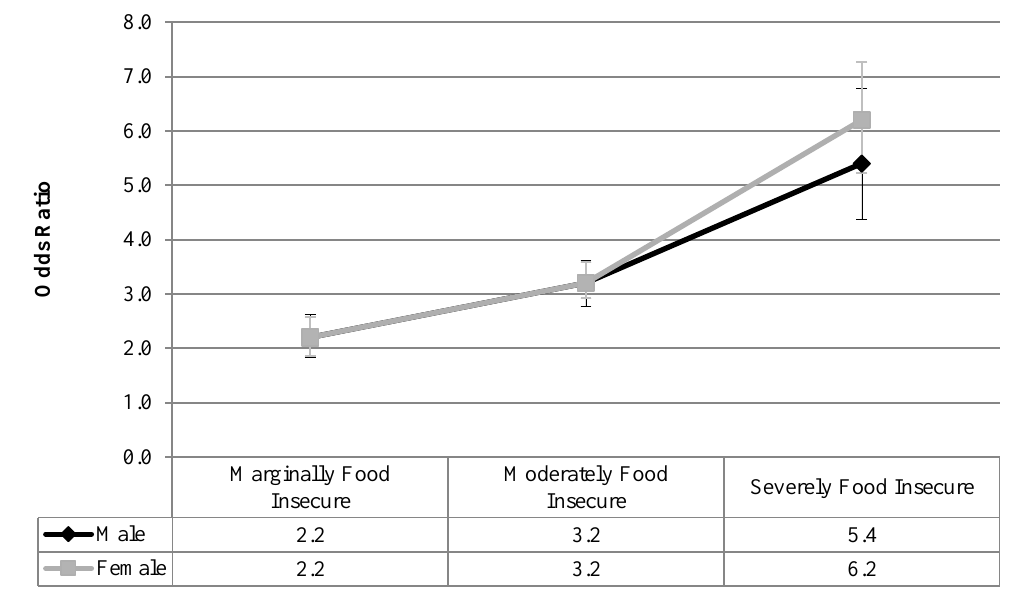
Figure 4. Odds ratio of reporting suicidal thoughts in the past month for each level of household food insecurity stratified by sex, compared with food secure; results from reduced binary logistic regression.